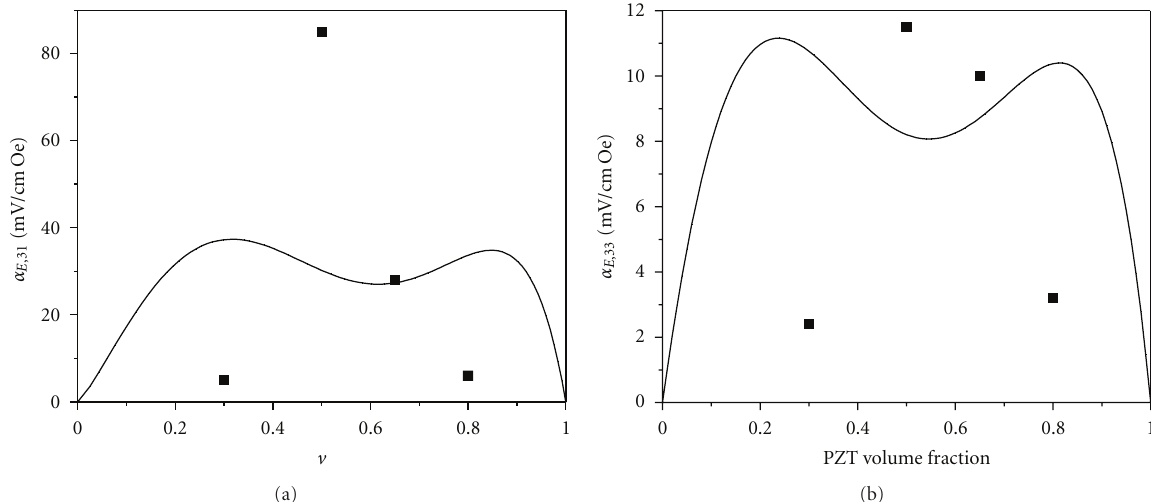
Figure 6: PZT volume fraction dependence of ME voltage coe ffi cients of CFO-PZT bilayer. Solid lines are theory for k = 0 . 1 and points are experiment.